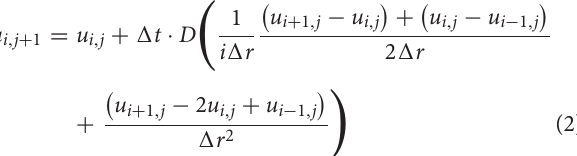
and (cid:49) x = 0 . 1 mm , respectively. The total observation time was t total = 17820 s = 4 . 95 h